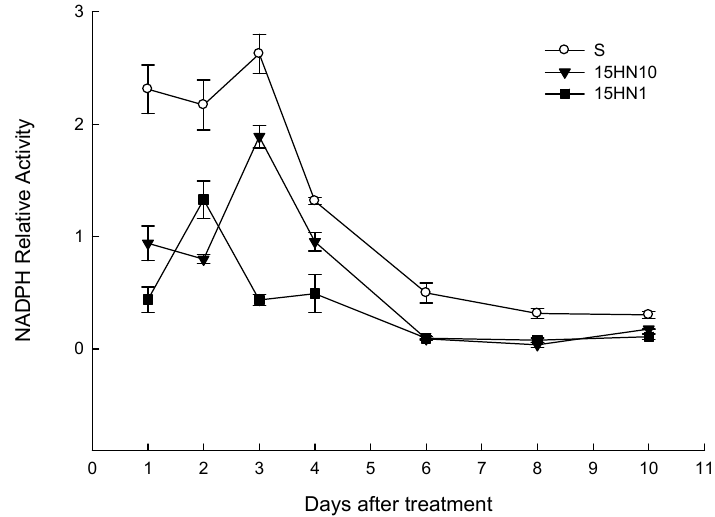
Figure 3. Relative activities of NADPH in resistant (15HN10, 15HN1) and susceptible (S) Digitaria sanguinalis populations.